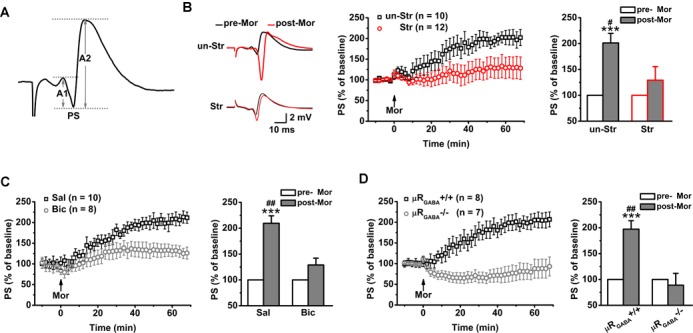
EP stress blocks the μRGABA-mediated reduction of GABAergic feedforward inhibition. The histograms in (B–D) show the average PS amplitude of the 5 min period immediately before and 55 min after morphine application, respectively. (A) The representative traces of evoked PSs. The PS amplitude was calculated using the formula (A1 + A2)/2. (B) The effects of morphine injection (15 mg/kg, i.p.) on the PS amplitude in unstressed and stressed wildtype mice. Treatment (morphine) F(1, 20) = 15.23, p = 0.001; group (stress) F(1, 20) = 4.64, p = 0.044; treatment × group F(1, 20) = 4.64, p = 0.044; R-M ANOVA. (C) The effects of morphine injection on the PS amplitude in unstressed wildtype mice pretreated with bicuculline or saline. Treatment (morphine) F(1, 16) = 29.72, p = 0.000; group (saline or bicuculline) F(1, 16) = 9.21, p = 0.008; treatment × group F(1, 16) = 9.21, p = 0.008; R-M ANOVA. (D) The effects of morphine injection on the PS amplitudes in unstressed μRGABA-/- mice and their littermates (μRGABA+/+). Treatment (morphine) F(1, 13) = 9.65, p = 0.008; genotype F(1, 13) = 15.26, p = 0.002; treatment × genotype F(1, 13) = 15.26, p = 0.002; R-M ANOVA. One symbol, p < 0.05; two symbols, p < 0.01; three symbols, p < 0.001; ∗paired Student’s t-test within-group; #unpaired t-test between-group. un-Str, unstressed; Str, stressed; Sal, saline; Bic, bicuculline; Mor, morphine; pre-Mor, baseline before morphine application; post-Mor, 55 min after morphine.